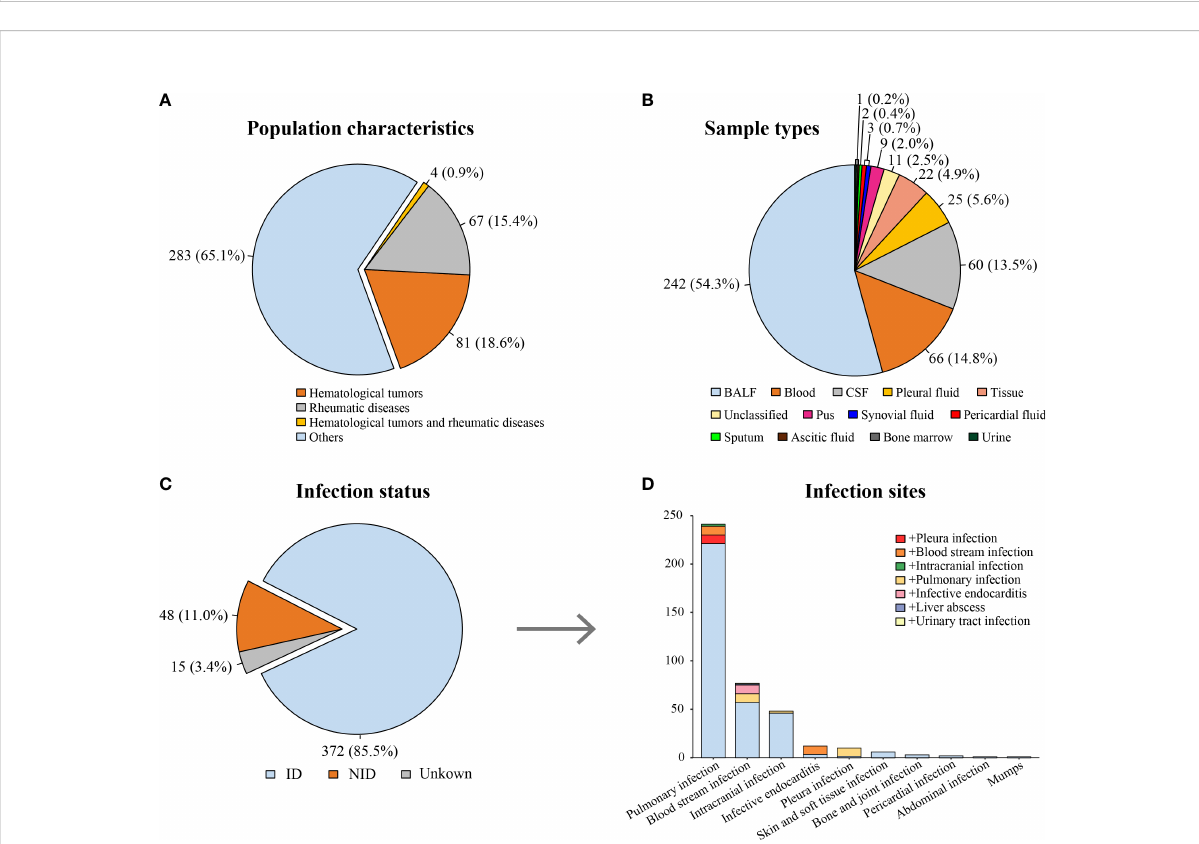
FIGURE 2 Characteristics of patients and specimens. (A) Proportion of patients suffering from hematological tumors or rheumatic diseases. (B) The distribution of specimens using for mNGS. (C) The distribution of infection status. (D) The distribution of infection sites in the ID group [the color block at the bottom of each column (light blue) indicates single site infection, whereas other color blocks indicate concurrent infection of other sites]. ID, infectious disease; NID, non-infectious disease; BALF, bronchial alveolar lavage fl uid; CSF, cerebrospinal fl